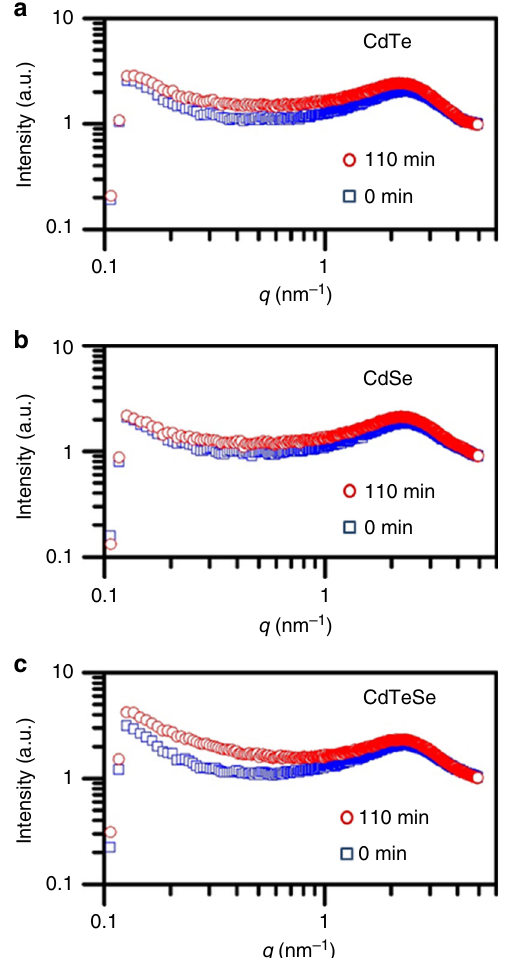
Fig. 6 In situ SAXS pro fi les for two binary samples and their mixture. The binary CdTe ( a ) and CdSe ( b ) samples were reacted at 130 and 140 °C, respectively, for 30 min and the mixture ( c ) was obtained at room temperature by mixing the binary samples with equal volumes. The SAXS data were collected each 10 min up to 110 min, with the spectra of 0 (blue squares) and 110 min (red circles) presented here. The SAXS study illustrates that the size of the three samples are clearly similar (as demonstrated by Supplementary Table 2 and Supplementary Fig.